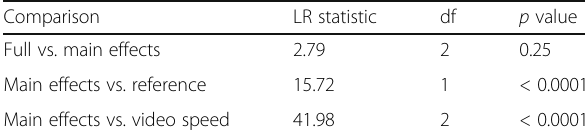
Table 1 Results of the model selection process